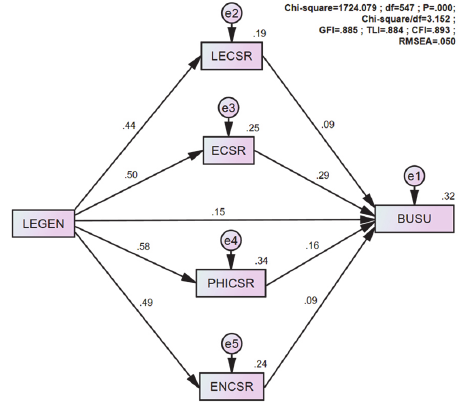
Fig. 2. Modified Structural Model with Estimated Path